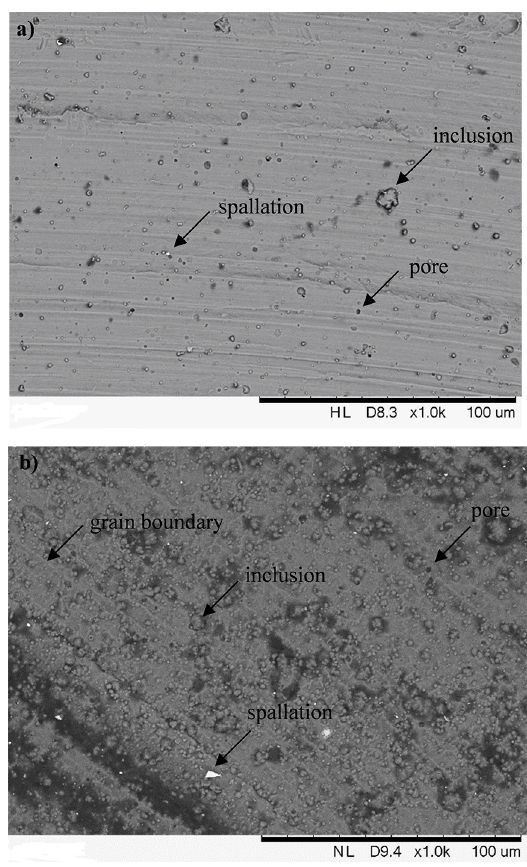
Figure 5. SEM images of PVD coated Ti–6Al–4V alloy surface before corrosion: a) TiN and b) TiAlN/TiAlCrN.